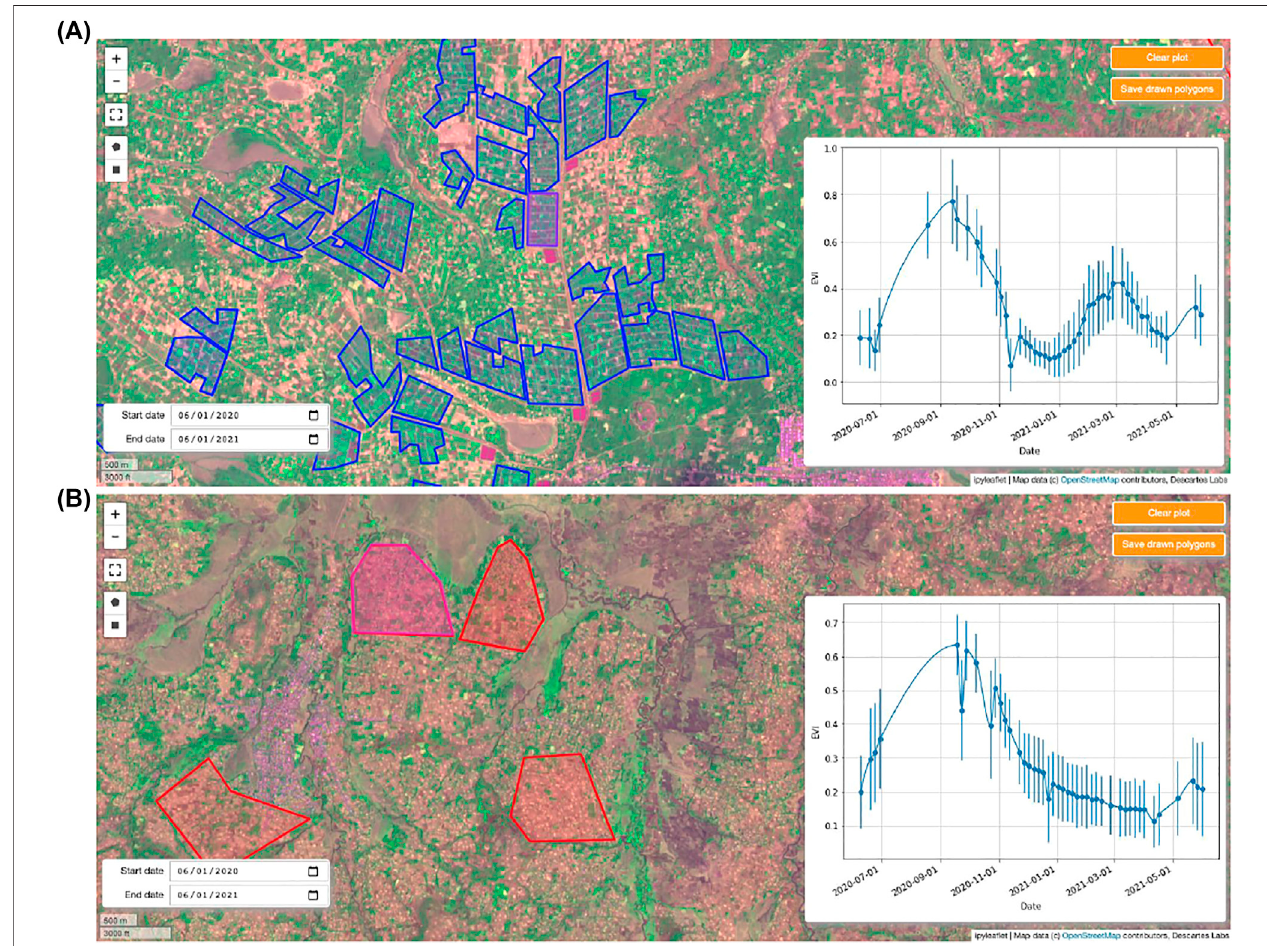
FIGURE 2 | Example of the visual collection (VC) labeling process in Koga using the Descartes Labs platform. Blue polygons denote areas determined to be irrigated; red polygons are determined to be non-irrigated. Background imagery is a false-color Sentinel-2 image taken in March 2021: Red, near-infrared, and blue bands are presented in the RGB channels, respectively. In (A) , the Sentinel-2 enhanced vegetation index (EVI) timeseries is shown for the drawn purple rectangle in the middle of the window; in (B) , the Sentinel-2 EVI timeseries is shown for the drawn pink, semi-octagonal polygon in the top left of the window. Both timeseries presentthemedianEVIvaluesforallpixelscontainedwithinthedrawnpolygon;theerrorbarsshowonestandarddeviationofthesevaluesaboveandbelowthemedian. In both fi gures, the drawn polygons are con fi rmed as VC labels, since they meet the de fi nitions of irrigation/non-irrigation, respectively.